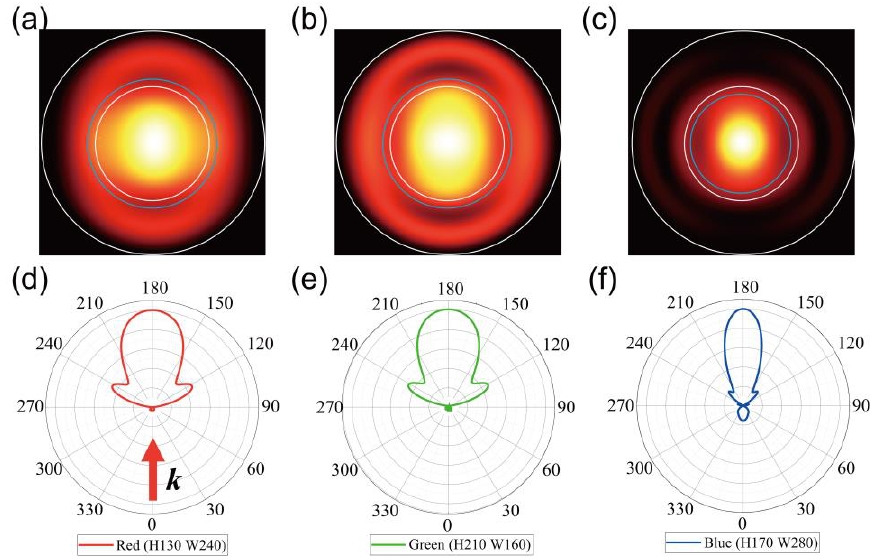
Figure 5. Far-field images of transmitted light for three representative structures with colors ( a ) red, ( b ) green, and ( c ) blue, described in Figure 3, for Ex polarized light. Here, the wavelengths of the incident light are 670, 510, and 480 nm, which are the peak wavelengths of the transmission spectra for three structures. The blue dashed circles indicate the boundary at which half of the total energy area is transmitted. The white solid line and white dotted circles indicate the boundary at 90° and 45° area from transmission direction, respectively. Polar graphs of the transmitted light for ( d ) red, ( e ) green, and ( f ) blue colored structures, respectively, obtained from far-field patterns of (a – c).